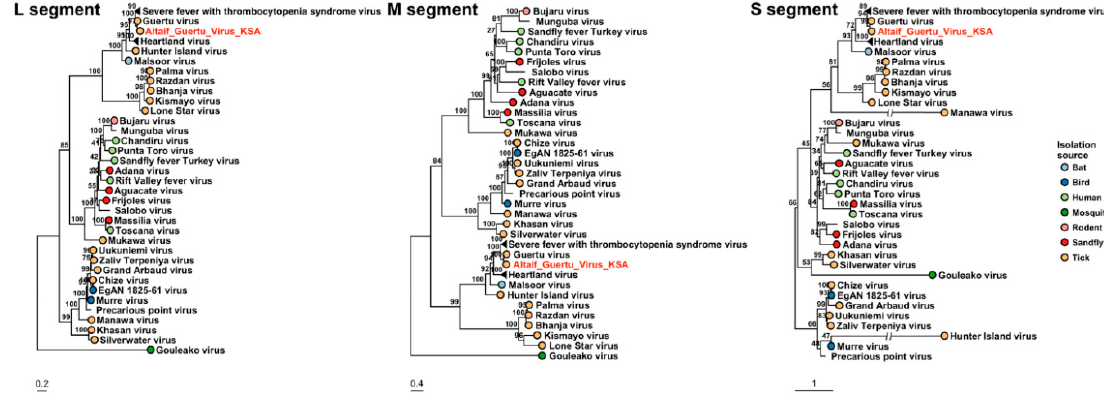
Figure 5. The phylogenetic trees based on L, M and S segments of the Bandaviruses (family Phenuiviridae ). The viruses detected in Saudi Arabia are marked with red color.